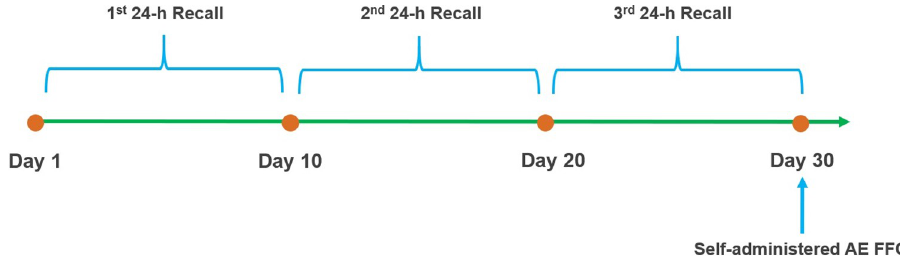
Fig 1. Design of the validation study of the AE-FFQ against three 24HRs among 60 adult Emiratis. 24HR = 24-hour dietary recall; AE-FFQ = Adult Emirati food frequency questionnaire.